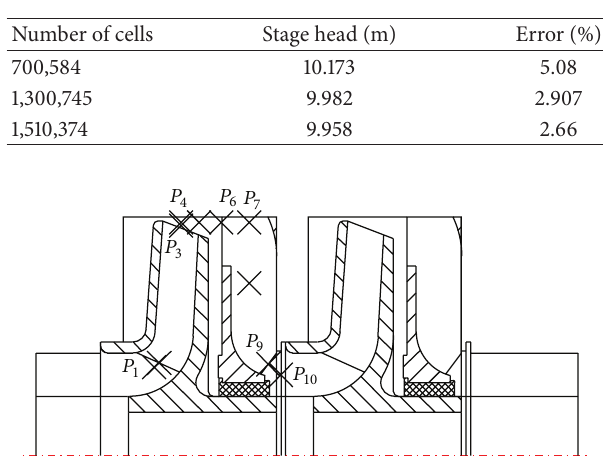
Figure 9: Pressure monitoring